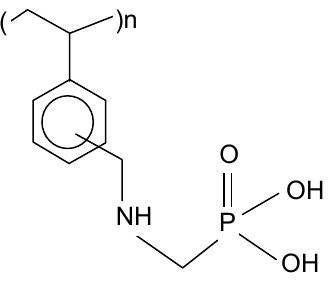
Figure 1. The selected physicochemical parameters of Purolite S 940 and Purolite S 950 are presented in Table 1.